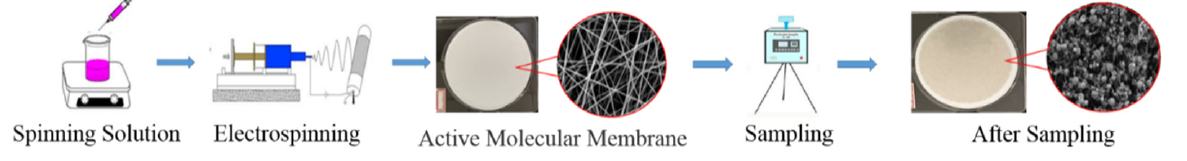
Scheme 1. Flow diagram of the preparation of electrospinning active molecular membrane and application for capturing free radicals.